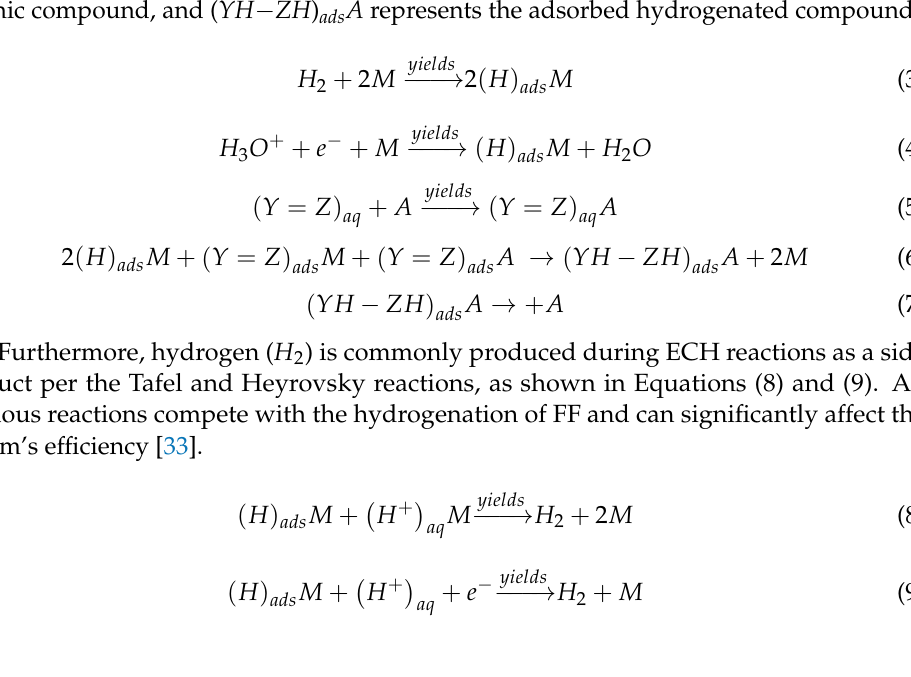
gen gas supply is required to reduce FF, as shown in Equation (3). In comparison, the ECH